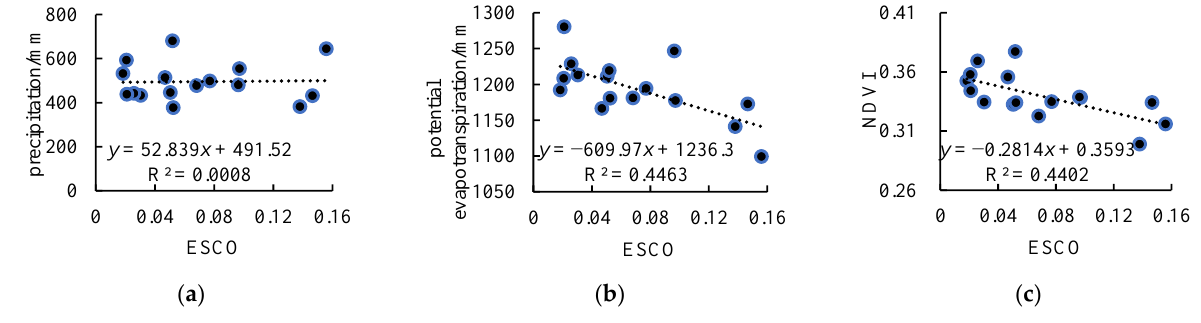
Figure 12. Correlation of ESCO to watershed precipitation, potential evapotranspiration, NDVI. ( a ) Precipitation, ( b ) potential evapotranspiration, ( c ) NDVI.